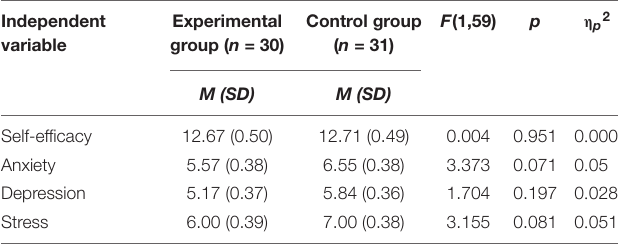
TABLE 1 | Comparison of the two groups in